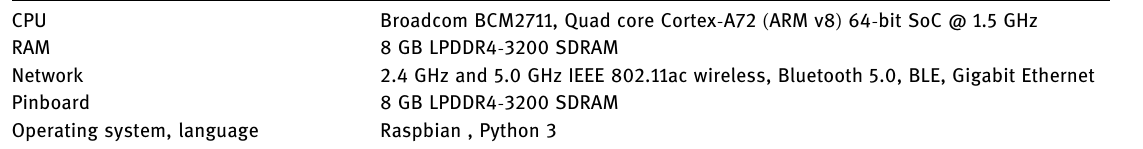
Table 3: Con fi guration of raspberry Pi